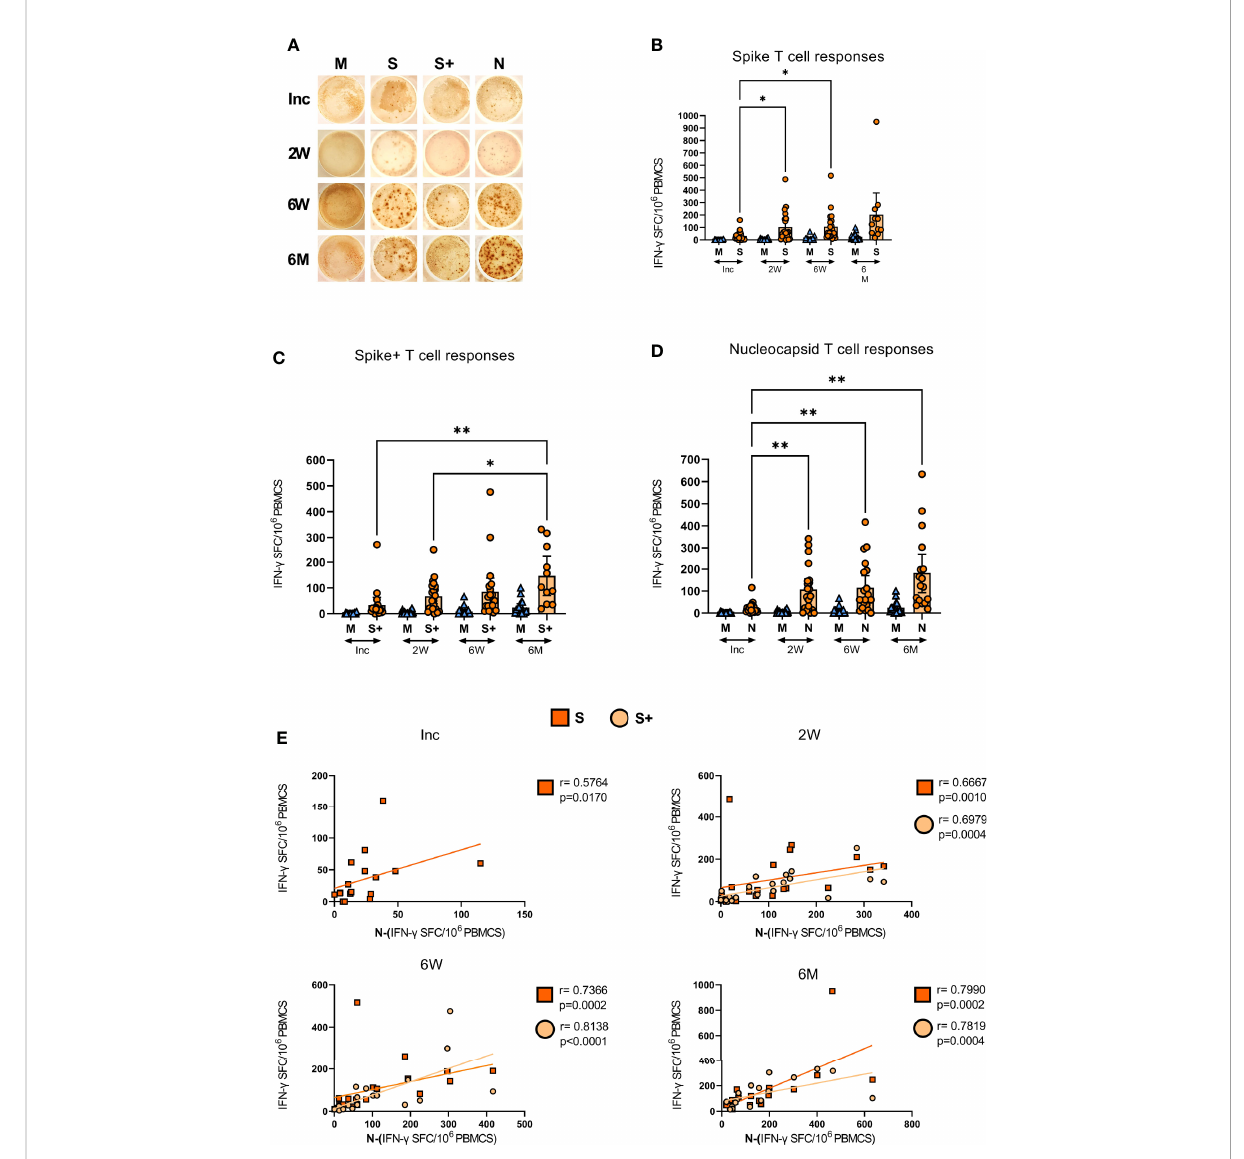
FIGURE 6 SARS-CoV-2-speci fi c IFN- g T cell responses in COVID-19 patients. PBMCs collected from COVID-19 patients that needed hospitalization (N=23) were left unstimulated (M) or incubated with SARS-CoV-2-speci fi c peptides: Spike (S), spike+ (S+), and nucleocapsid (N); and assessed for their production of IFN- g by ELISPOT. (A) Representative images of the IFN- g production in a COVID-19 hospitalized patient at inclusion, 2 weeks, 6 weeks, and 6-7 months, each dot represents one antigen-speci fi c T cell. Antigen-speci fi c T cell responses as spot forming cells (SFC) per 10 6 PBMCs, speci fi c for (B) spike, (C) spike+, and (D) nucleocapsid antigens. (E) Bivariate analysis with Spearman ’ s correlation coef fi cient was performed on spike, spike+ and nucleocapsid T cell responses with Spearman ’ s correlation coef fi cient (R) and p values shown. Data is represented as mean with 95% Cl, with signi fi cance of *p ≤ 0.05, **p ≤ 0.01, determined using Brown-Forsythe and Welch ANOVA tests. Inc = Inclusion in study at the hospital, 2W = 2 weeks, 6W = 6 weeks, 6M = 6-7 months, HC = healthy